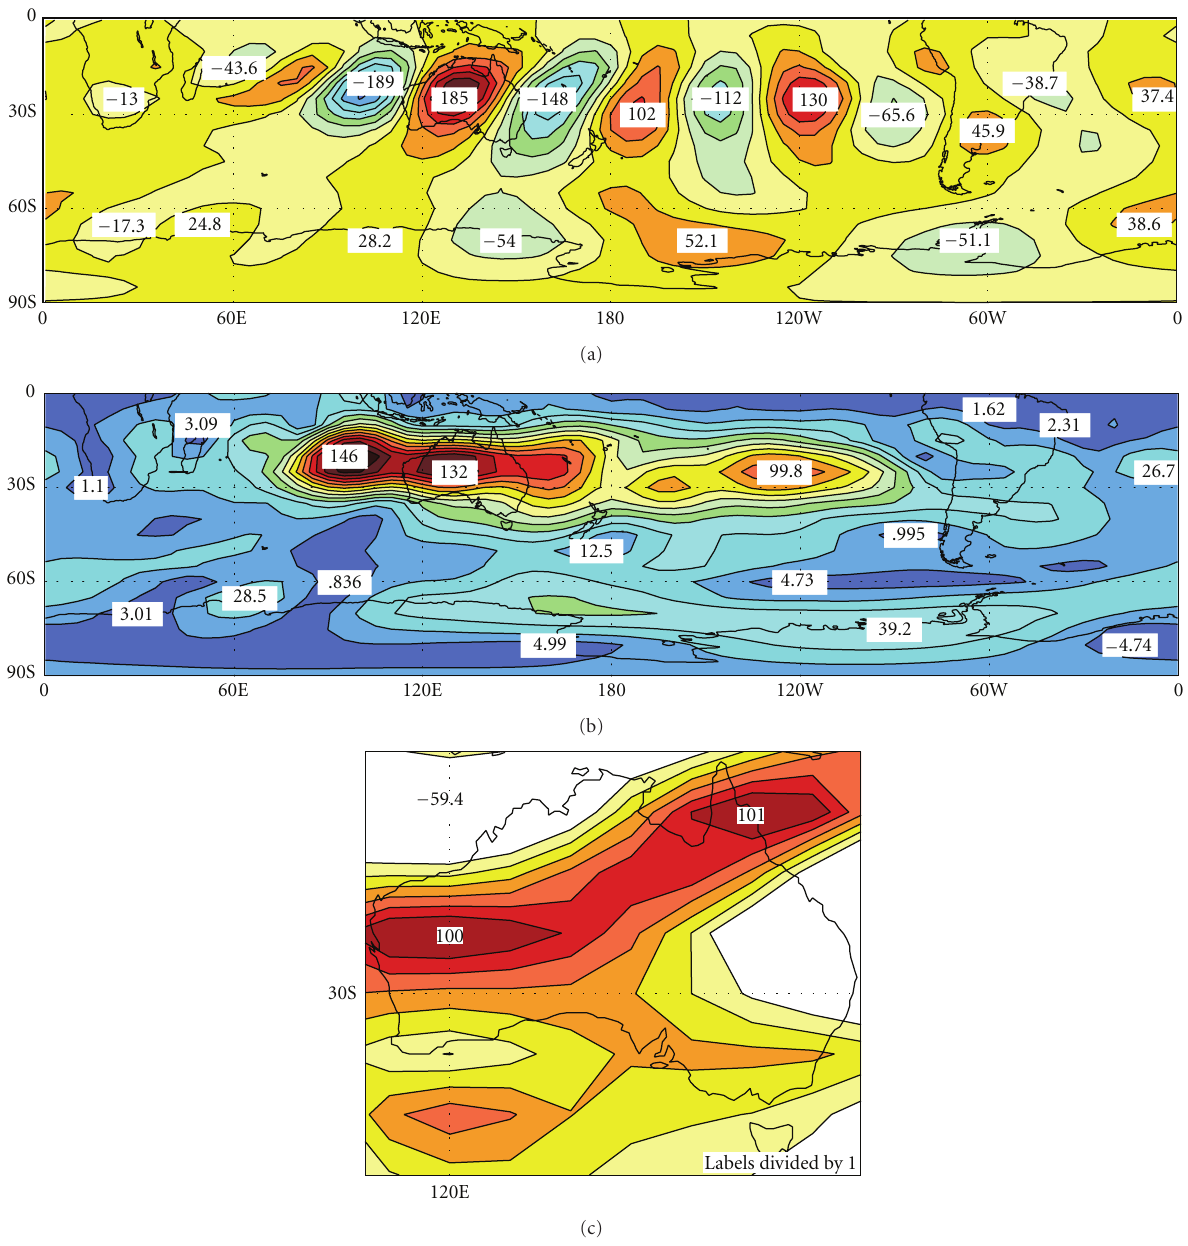
Figure 6: As in Figure 4 but for the SH upper-level streamfunction (a), the RPEA of the upper-level streamfunction (b), and the upper-level divergence in the Australian region (c) for the leading NWCB mode, mode 12, for the July 1975–94 basic